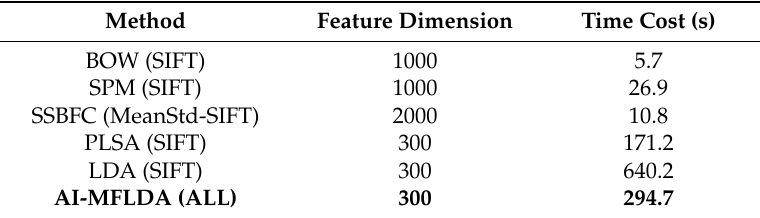
Table 3. Feature dimensions and time costs of the different methods in the experiments.